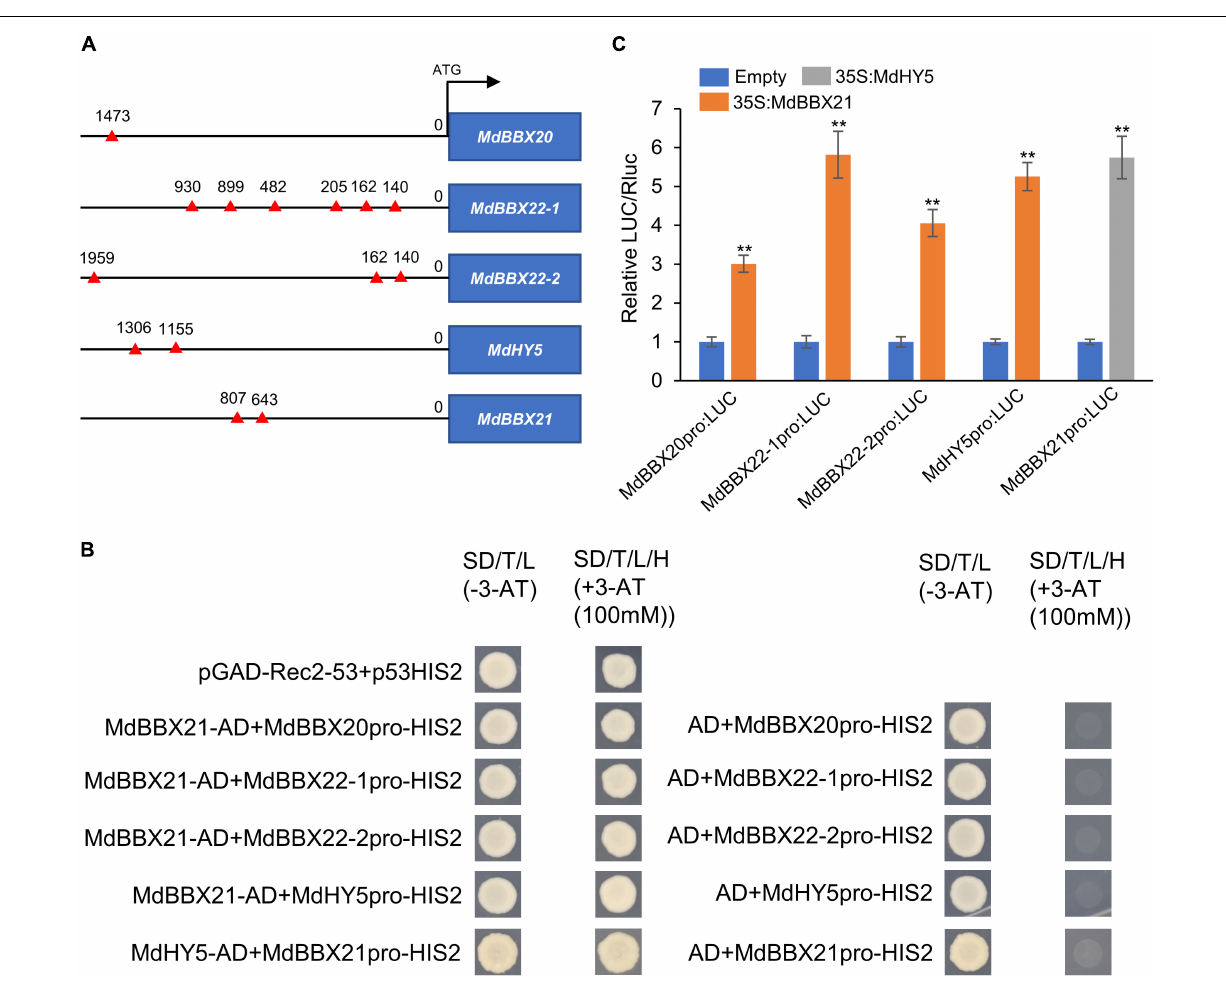
FIGURE 7 | MdBBX21 binds directly to the MdHY5 , MdBBX20 , and MdBBX22 - 1 / 2 promoters and induces expression. (A) The characteristics of G-box motif in the promoters of MdHY5 , MdBBX20 , and MdBBX22 - 1 / 2 . The red triangle represents G-box motif. (B) Yeast one-hybrid assays identified interaction of MdBBX21 with the promoters of MdHY5 , MdBBX20 , and MdBBX22 - 1 / 2 . (C) The effects of MdBBX21 on the promoter activity of MdHY5 , MdBBX20 , and MdBBX22 - 1 / 2 with the dual-luciferase reporter assay. Error bars represent the standard deviation of three biological replicates. ** P < 0.01 (Student’s t